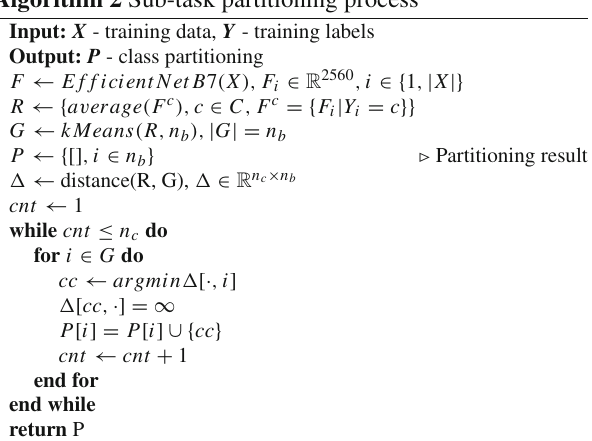
Algorithm 2 Sub-task partitioning process